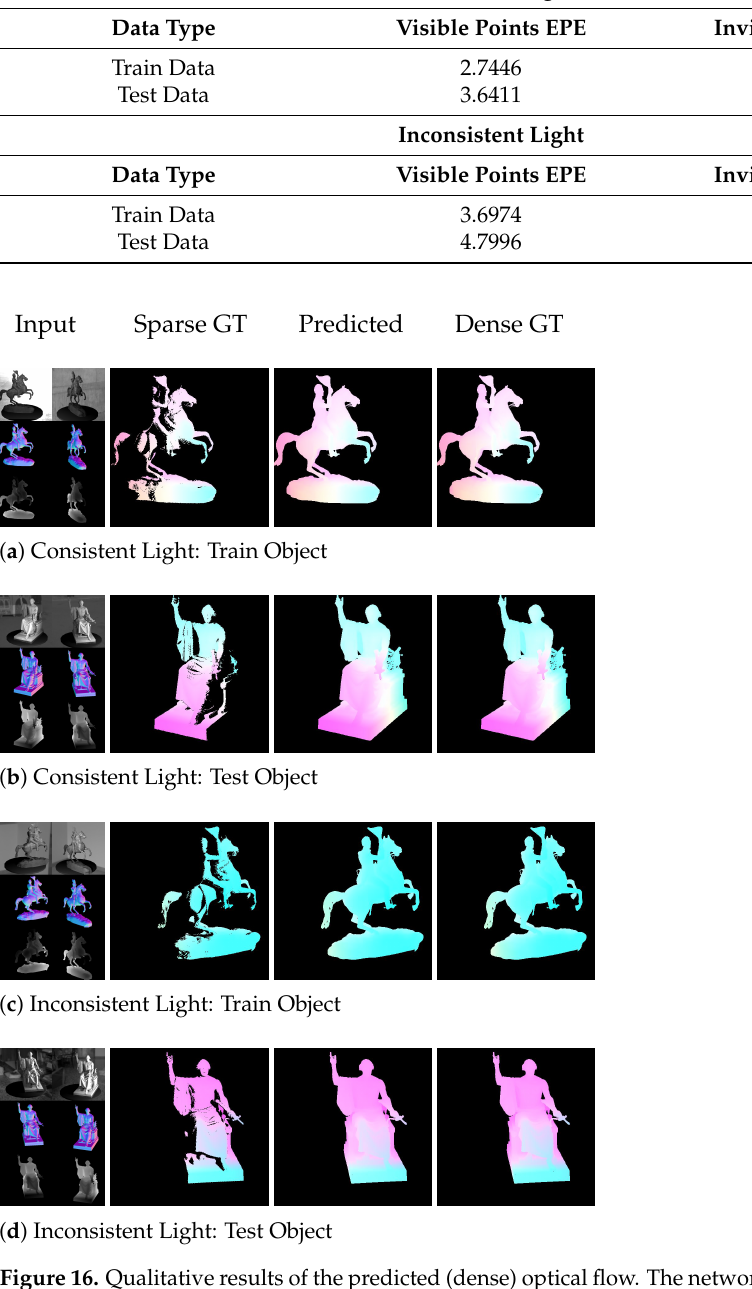
Figure 16. Qualitative results of the predicted (dense) optical flow. The network allows for computing accurate flows for invisible pixels from the context of visible parts as well as for the consistent and inconsistent